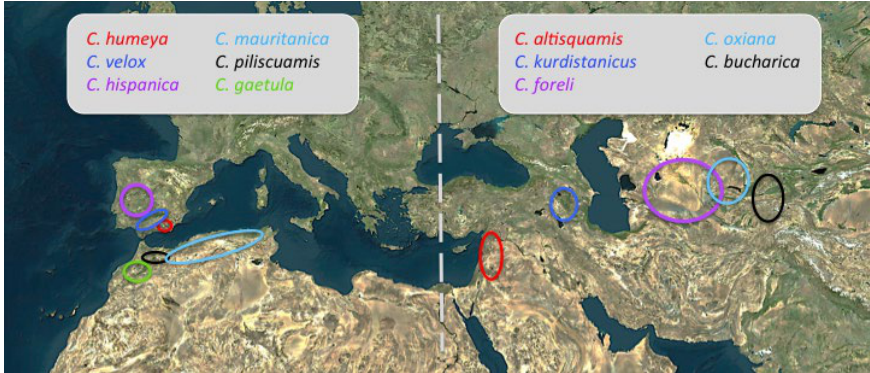
Figure 11. Disjunct distribution of the species belonging to the Cataglyphis altisquamis group (modified from [149]; base map as in Figure 9).